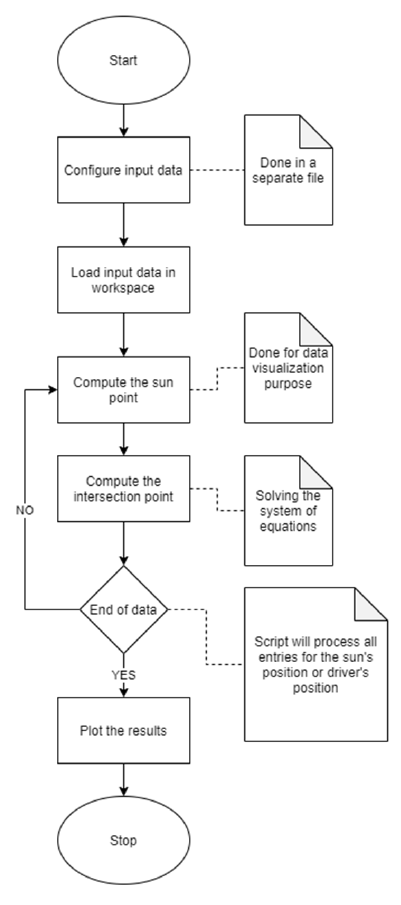
Figure 12. Simulation flow chart.